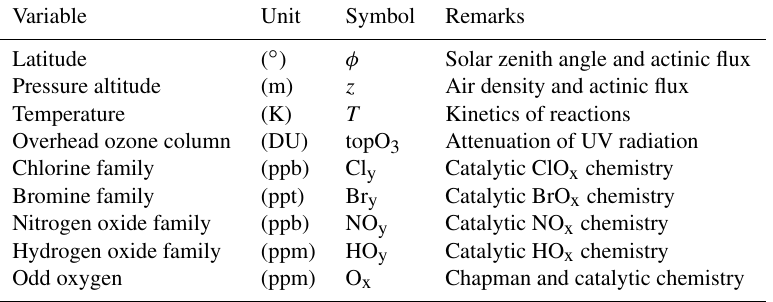
) and overhead ozone is the integrated ozone column above a specific location in the p 0